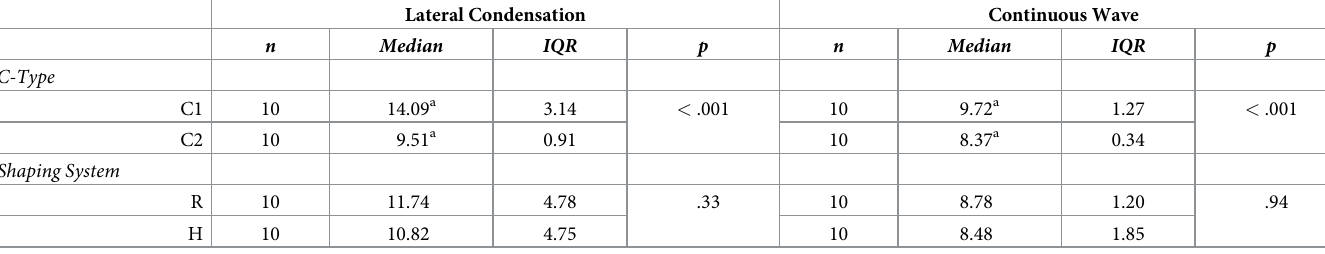
Table 1. Descriptive statistics of time spent(in minutes) for filling and the results of Mann-Whitney U group statistics. Lateral Condensation Continuous Wave